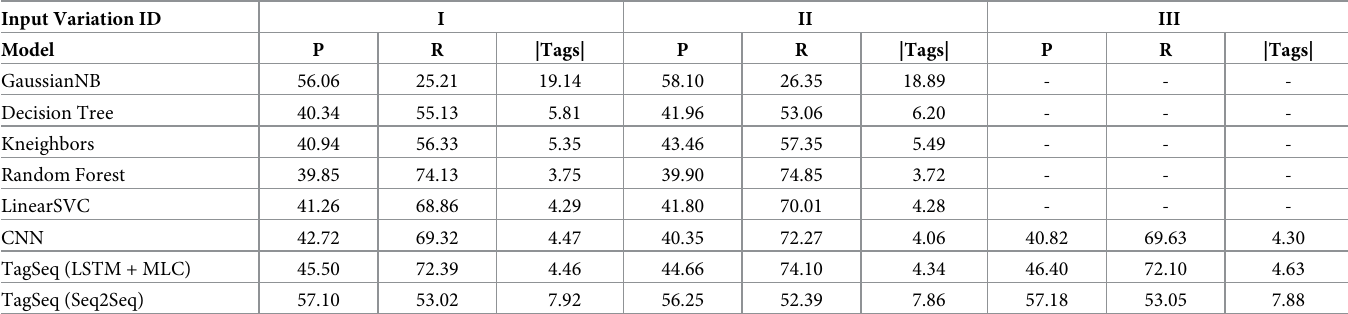
Table 6. Experimental results for different